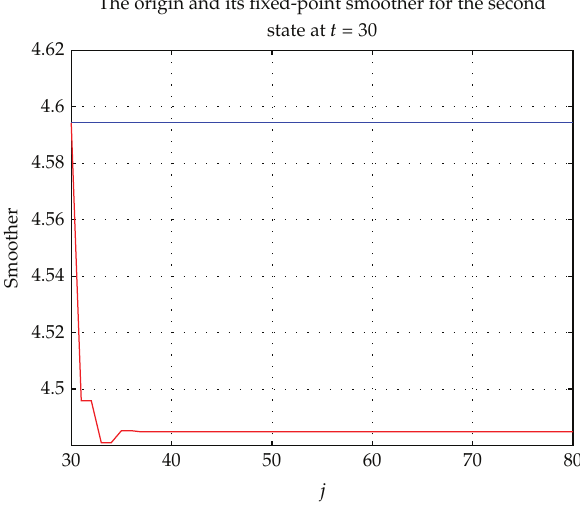
Figure 2: The origin and its fixed-point smoother (cid:13) x 2 (cid:2) 30 | j (cid:3) , where the blue line is the origin signal, the red line is the smoother.